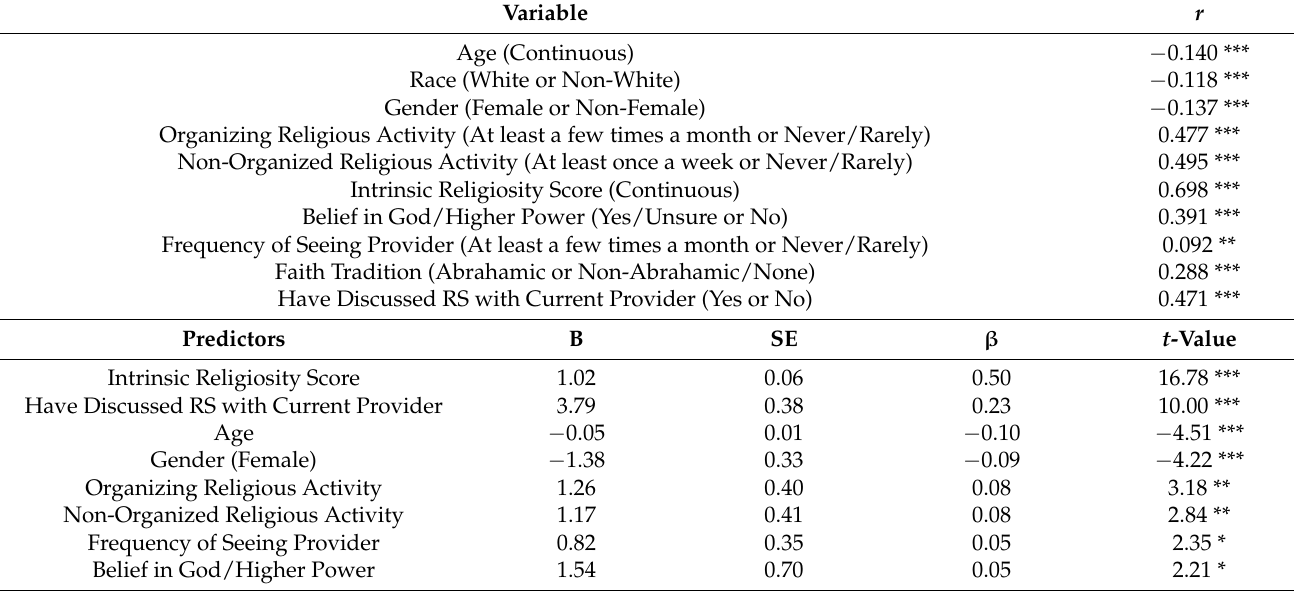
Table 4. Relationships Between Client Characteristics and Summary of Multiple Regression ( n =